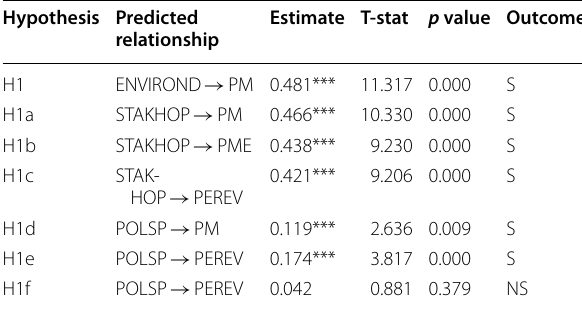
*** 0.01%, ** 0.05%; the coefficients are standardized beta values = = S supported, NS not supported